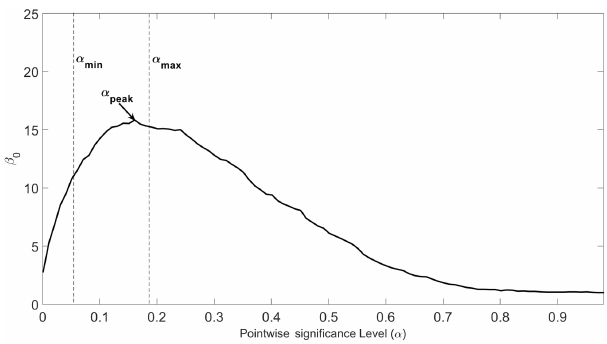
Figure 5. The mean number of patches as a function of α . The curve was obtained by generating 100 wavelet power spectra of red-noise processes of length 300 and computing β 0 for each of the wavelet power spectra at each pointwise significance level. The quantities α min and α max are the lower and upper bounds of the computation interval for the cumulative areawise test and α peak is the pointwise significance level for which the number of patches reaches a maxi- mum within the computation interval.